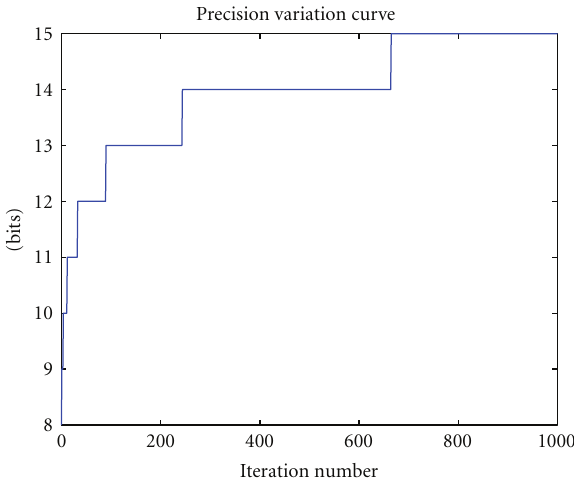
Figure 1: Precision variation curve for the accumulator in (4) [19,